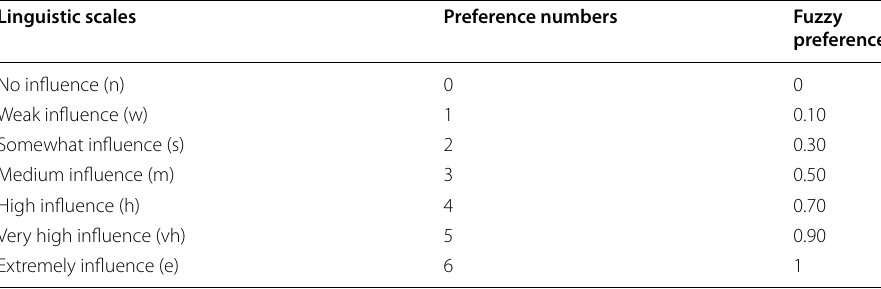
Table 3 Linguistic scales and fuzzy preference numbers Linguistic